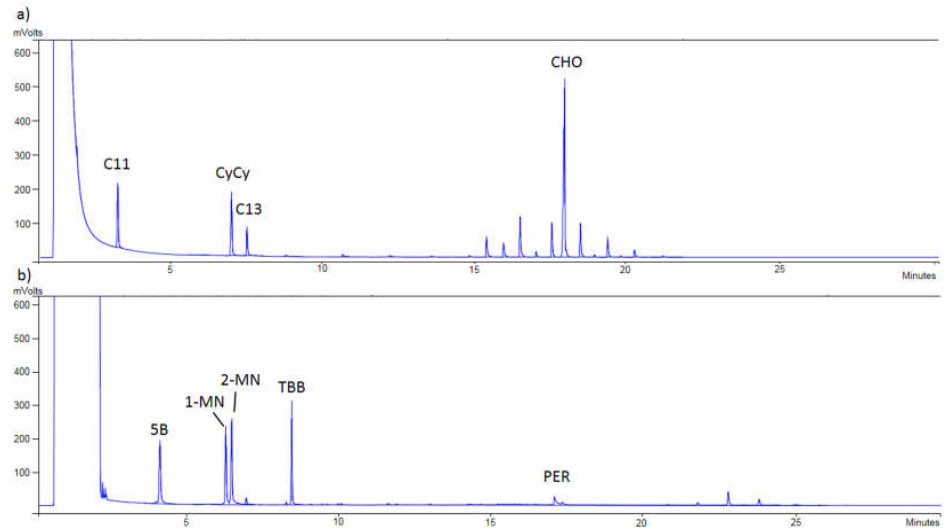
Figure 1. ( a ) Chromatogram of the mineral oil saturated hydrocarbons (MOSH) of an extracted blank sample at 10 mg/kg; (C11: n -undecane; CyCy: bicyclohexyl; C13: n -tridecane; CHO: cholestane). ( b ) Chromatogram of the mineral oil aromatic hydrocarbons (MOAH) of an extracted blank sample spiked at 10 mg/kg; (5B: pentylbenzene; 1-MN: 1-methylnaphthalene; 2-MN: 2-methylnaphthalene; TBB: 1,3,5-tri-tert-butylbenzene; PER: